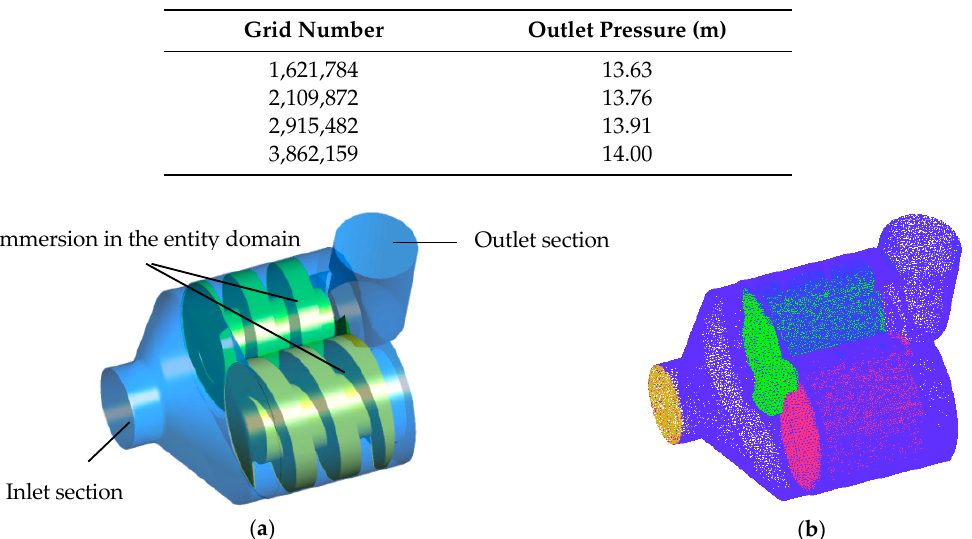
Figure 3. Three-dimensional model and grid of the calculation domain. ( a ) Three-dimensional modelling; ( b ) grid-generated graph.